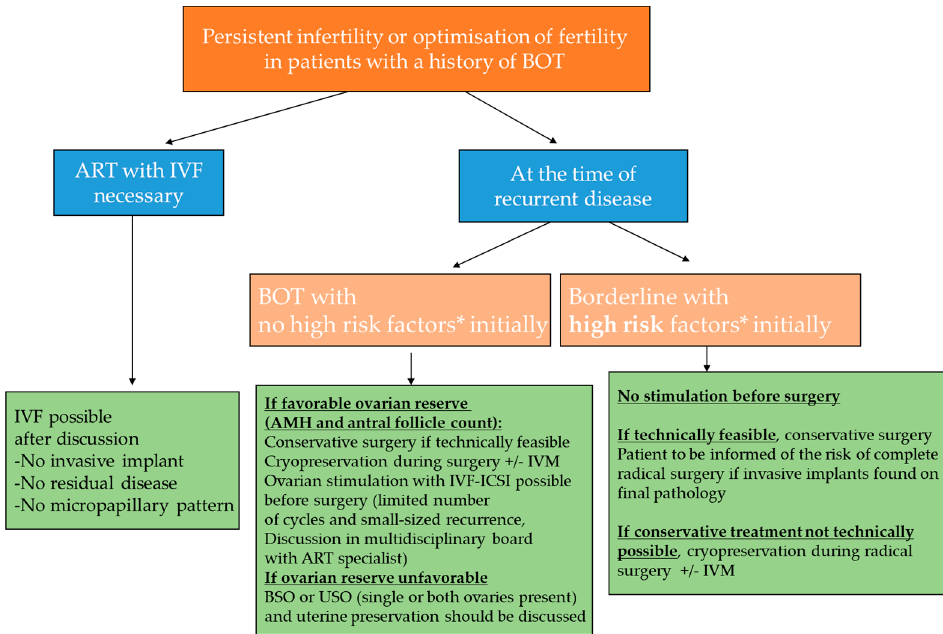
Figure 1. Management of infertility (or optimization of infertility) in a young patient with previous history of BOT (ART, assisted reproductive technology; IVF, in vitro fertilization; ICSI, intracytoplasmic sperm injection; IVM, in vitro maturation; BSO, bilateral salpingo-oophorectomy; USO, unilateral salpingo-oophorectomy; AMH: anti-Mullerian hormone; * High-risk recurrent borderline tumor: defined by a recurrent case presenting radiologic (on magnetic resonance imaging) or clinical (recurrence associated with implants) suspicious lesion at the time of the recurrence or histologic high risk factors (peritoneal implants, mucinous tumor with intraepithelial carcinoma, micropapillary patterns, stromal microinvasion) during the treatment of the first tumor (ref Darai et al. Human reprod 2013).